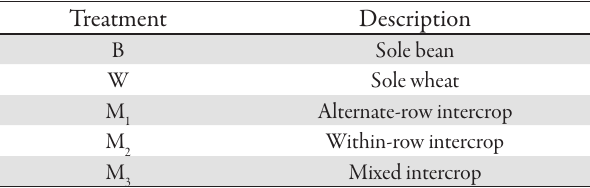
Tab. 1. The description of experimental treatments Treatment